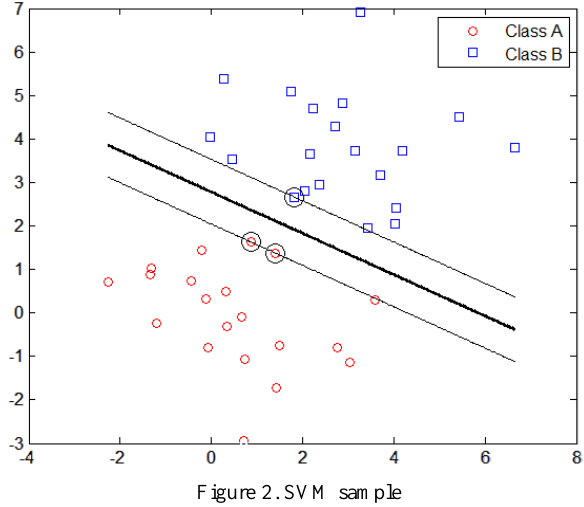
Figure 2. SVM sample